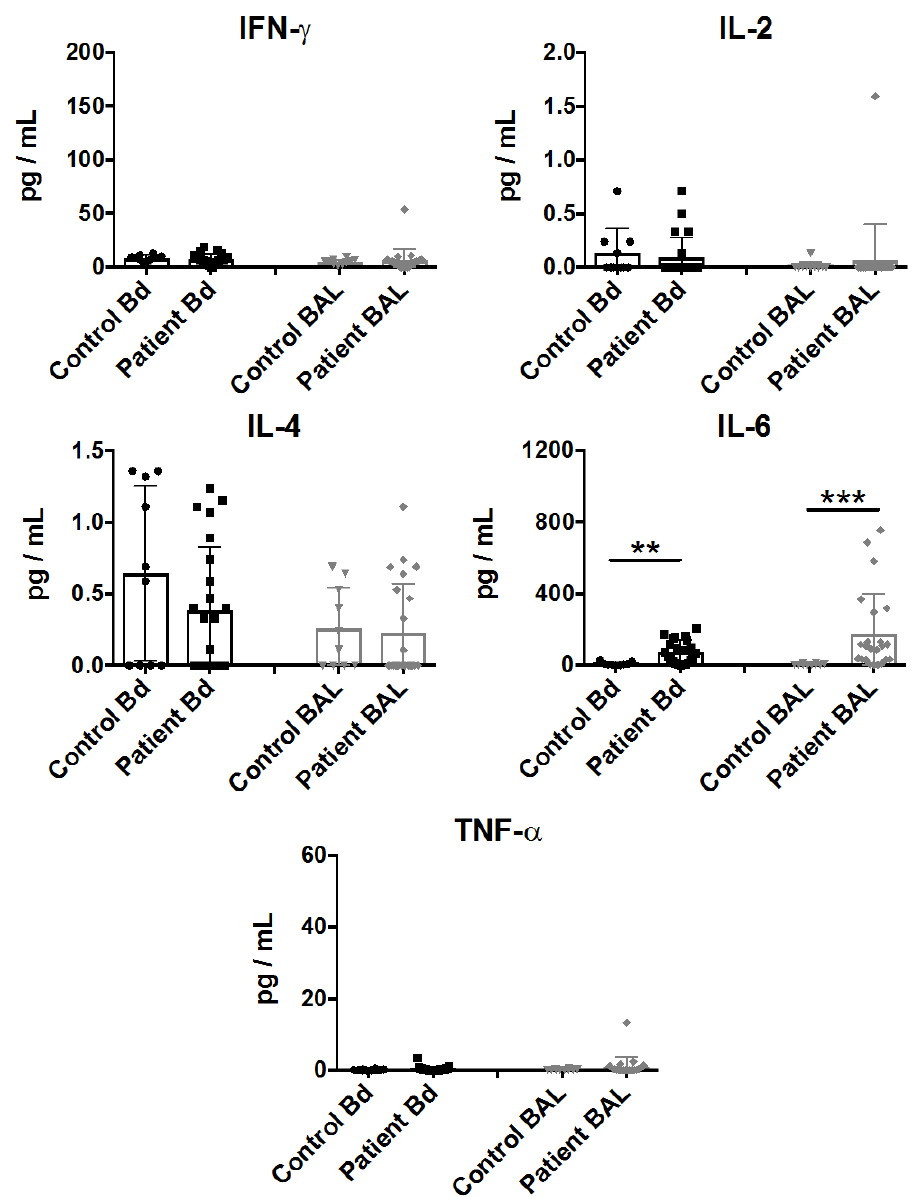
Figure 1. Cytokine profiling of plasma (represented by Bd) and bronchoalveolar lavage (BAL) fluid from sepsis patient samples. Cytokine assessment was performed on plasma or BAL fluid samples which were collected within 48 h of clinical classification of severe sepsis and ICU admission. IFN-γ, IL-2, IL-4, IL-6, and TNF-α levels are represented as pg/mL in mean ± SEM, with all data from individual controls or patients. Statistical analysis was performed using the Mann-Whitney test, where ** p < 0.01, or *** p < 0.001 were considered for statistical significance.